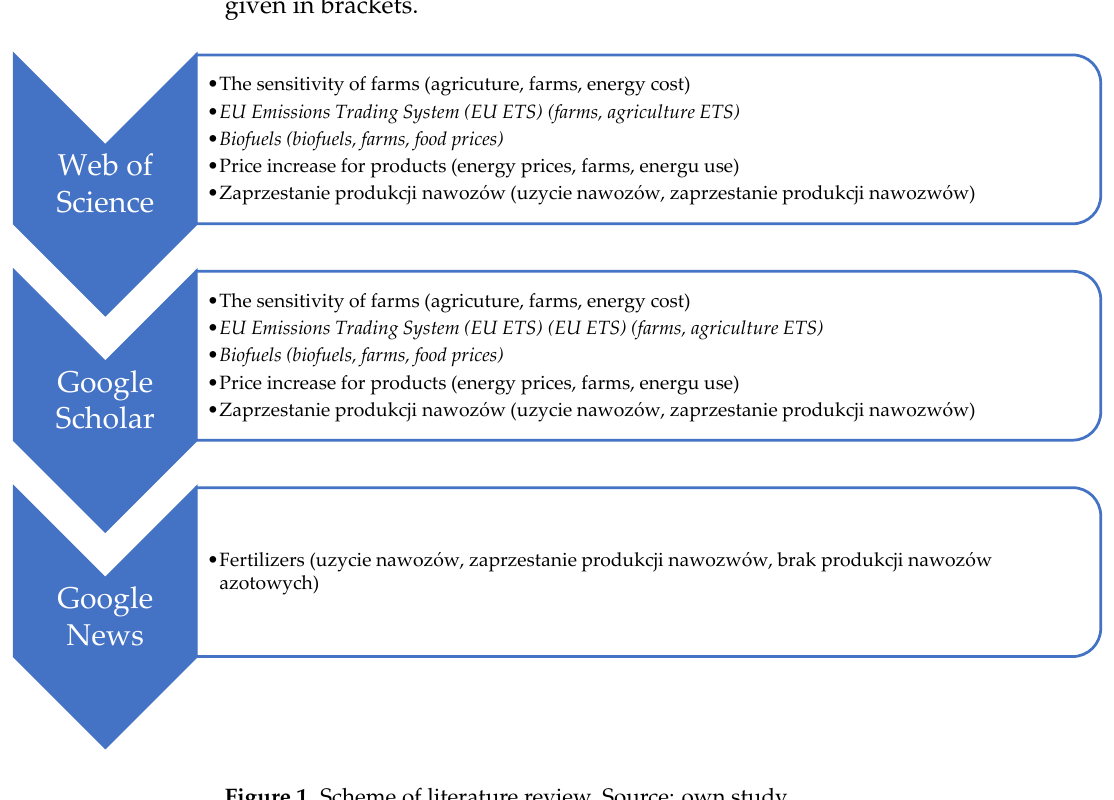
Figure 1. Scheme of literature review. Source: own study.